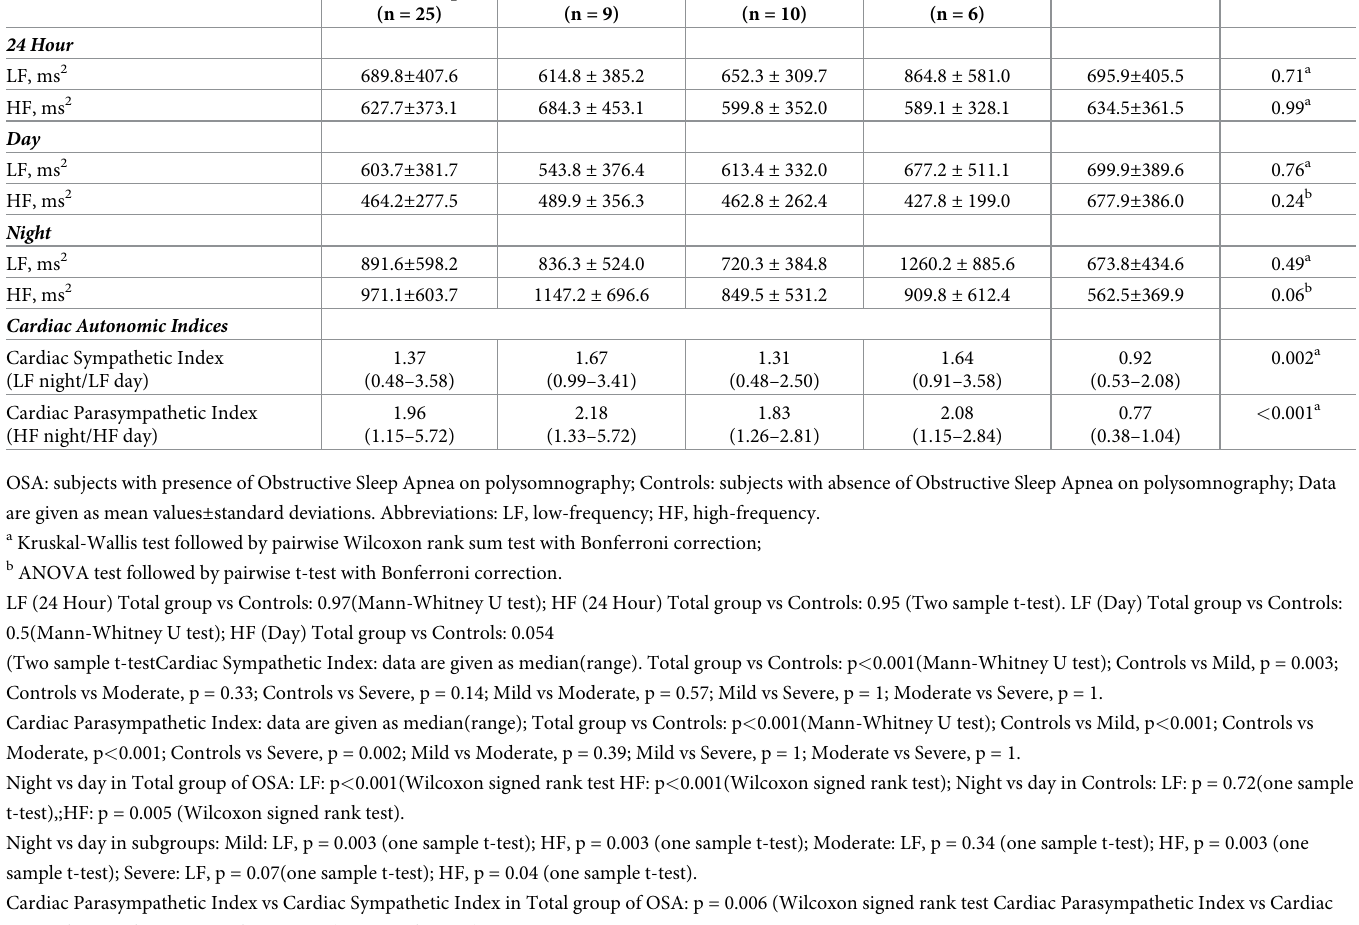
Table 2. Heart rate variability parameters in OSA patients and controls. HRV Parameters